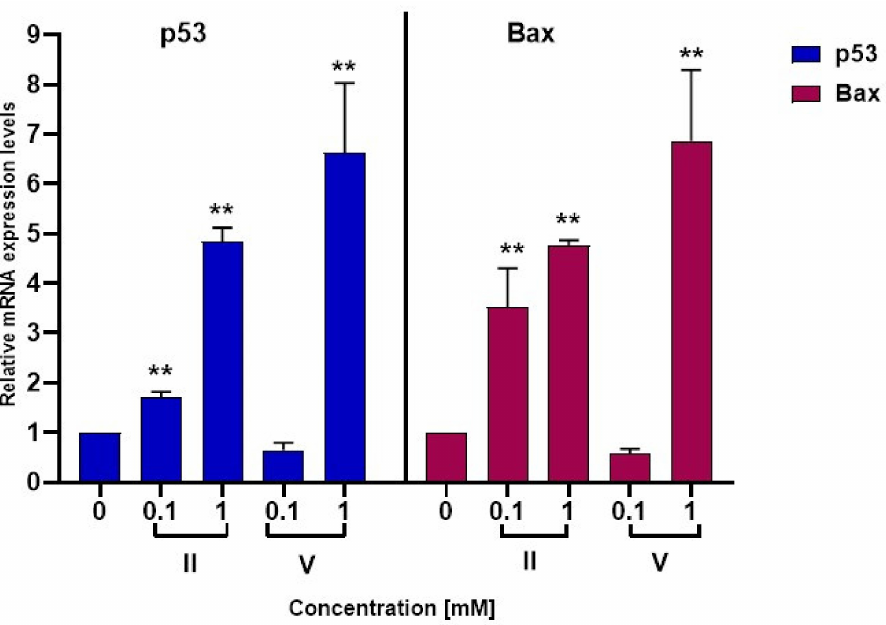
Figure 9. Multiple Myeloma cell line H929 was treated with compound II and compound V for 48 h and mRNA extraction was performed. The mRNA expression levels were measured by qRT-PCR. An increase in Bax and p53 mRNA transcription was observed upon treatment with the indicated compounds. One-way ANOVA followed by Bonferroni post hoc test were used to assess significant differences between the treatment groups and the vehicle control. ** p <